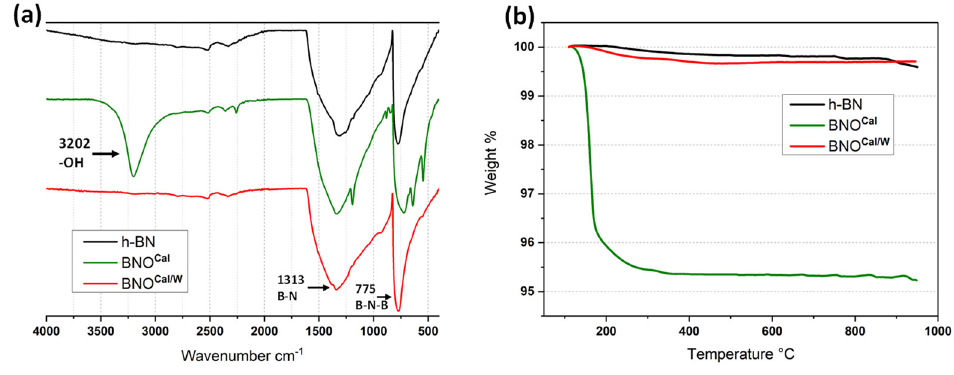
Figure 3. FTIR spectra ( a ) and TGA thermograms ( b ) of h-BN, BNO Cal , and BNO Cal/W samples.